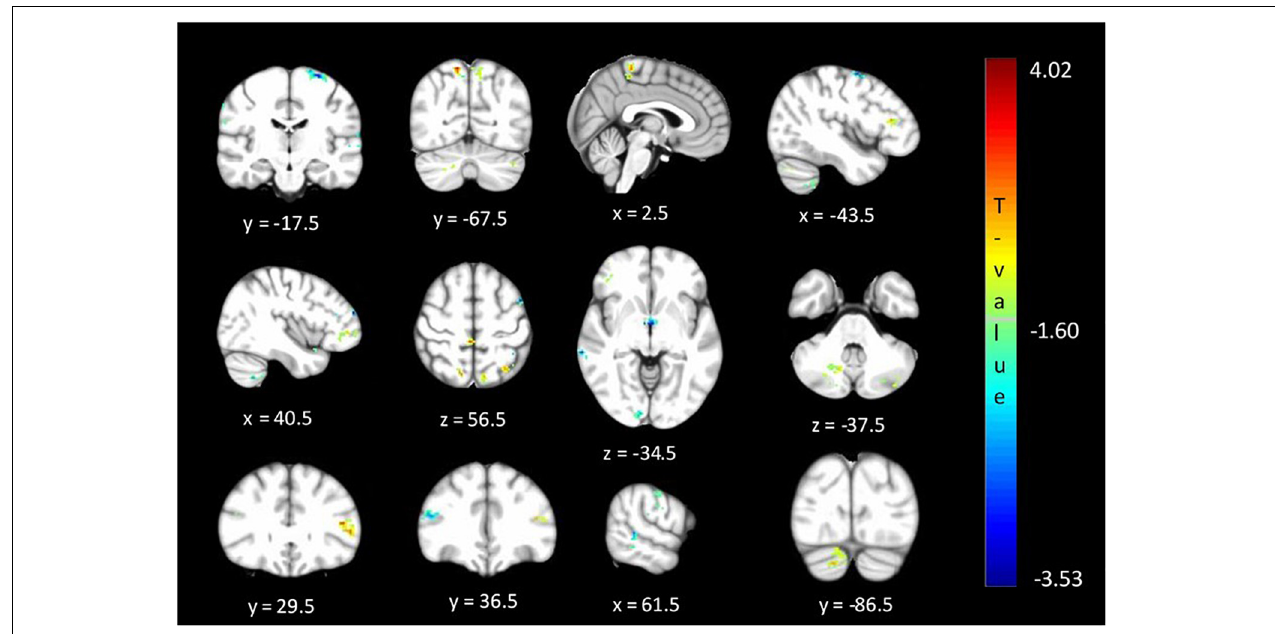
The columns denote the clusters’ x, y, z coordinates in mm, the area represented by them, side of the brain and function of the region. Clusters with voxel p < 0.005 and cluster size > 534 mm 3 have been reported.